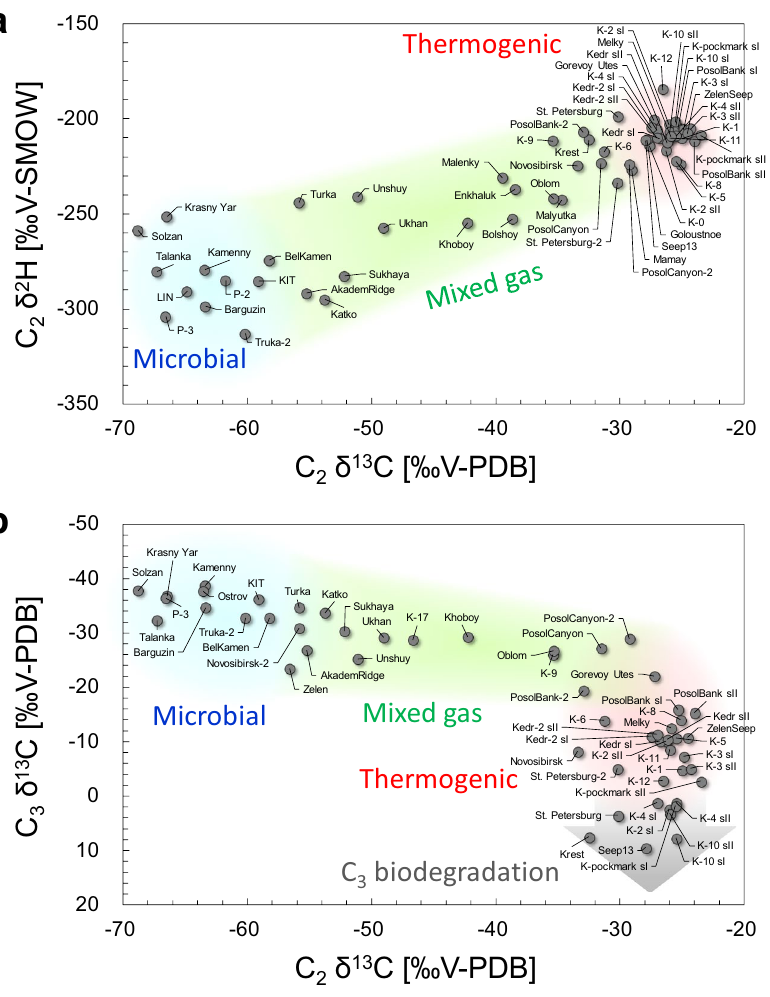
Figure 3. Stable isotope compositions of C 2 and C 3 . ( a ) Relation between C 2 δ 2 H and C 2 δ 13 C. ( b ) Relation between C 3 δ 13 C and C 2 δ 13 C. The data for Malenky, Bolshoy, Malyutka, P-2, K-0, K-2 and Goloustnoe are sourced partly from Hachikubo et al. 33 . The data for Kedr and Kedr-2 are sourced partly from Hachikubo et al. 41